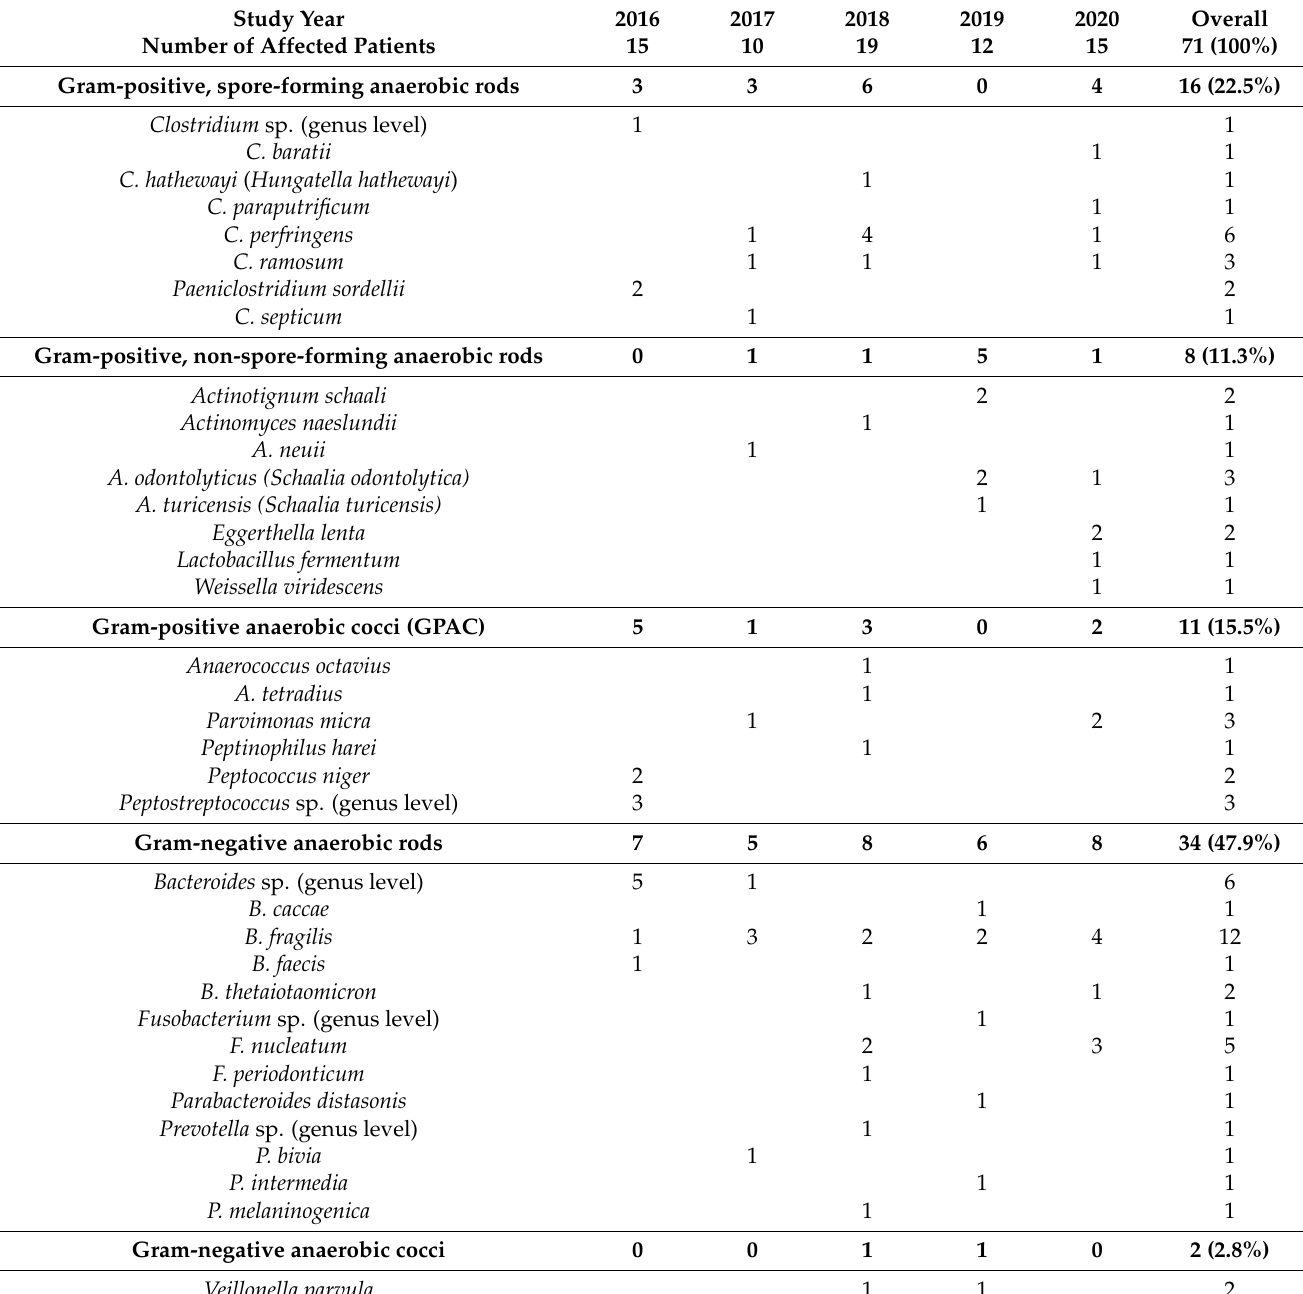
Table 3. Detailed species distribution of clinically relevant anaerobic isolates from anaerobic bac- teremia in our study